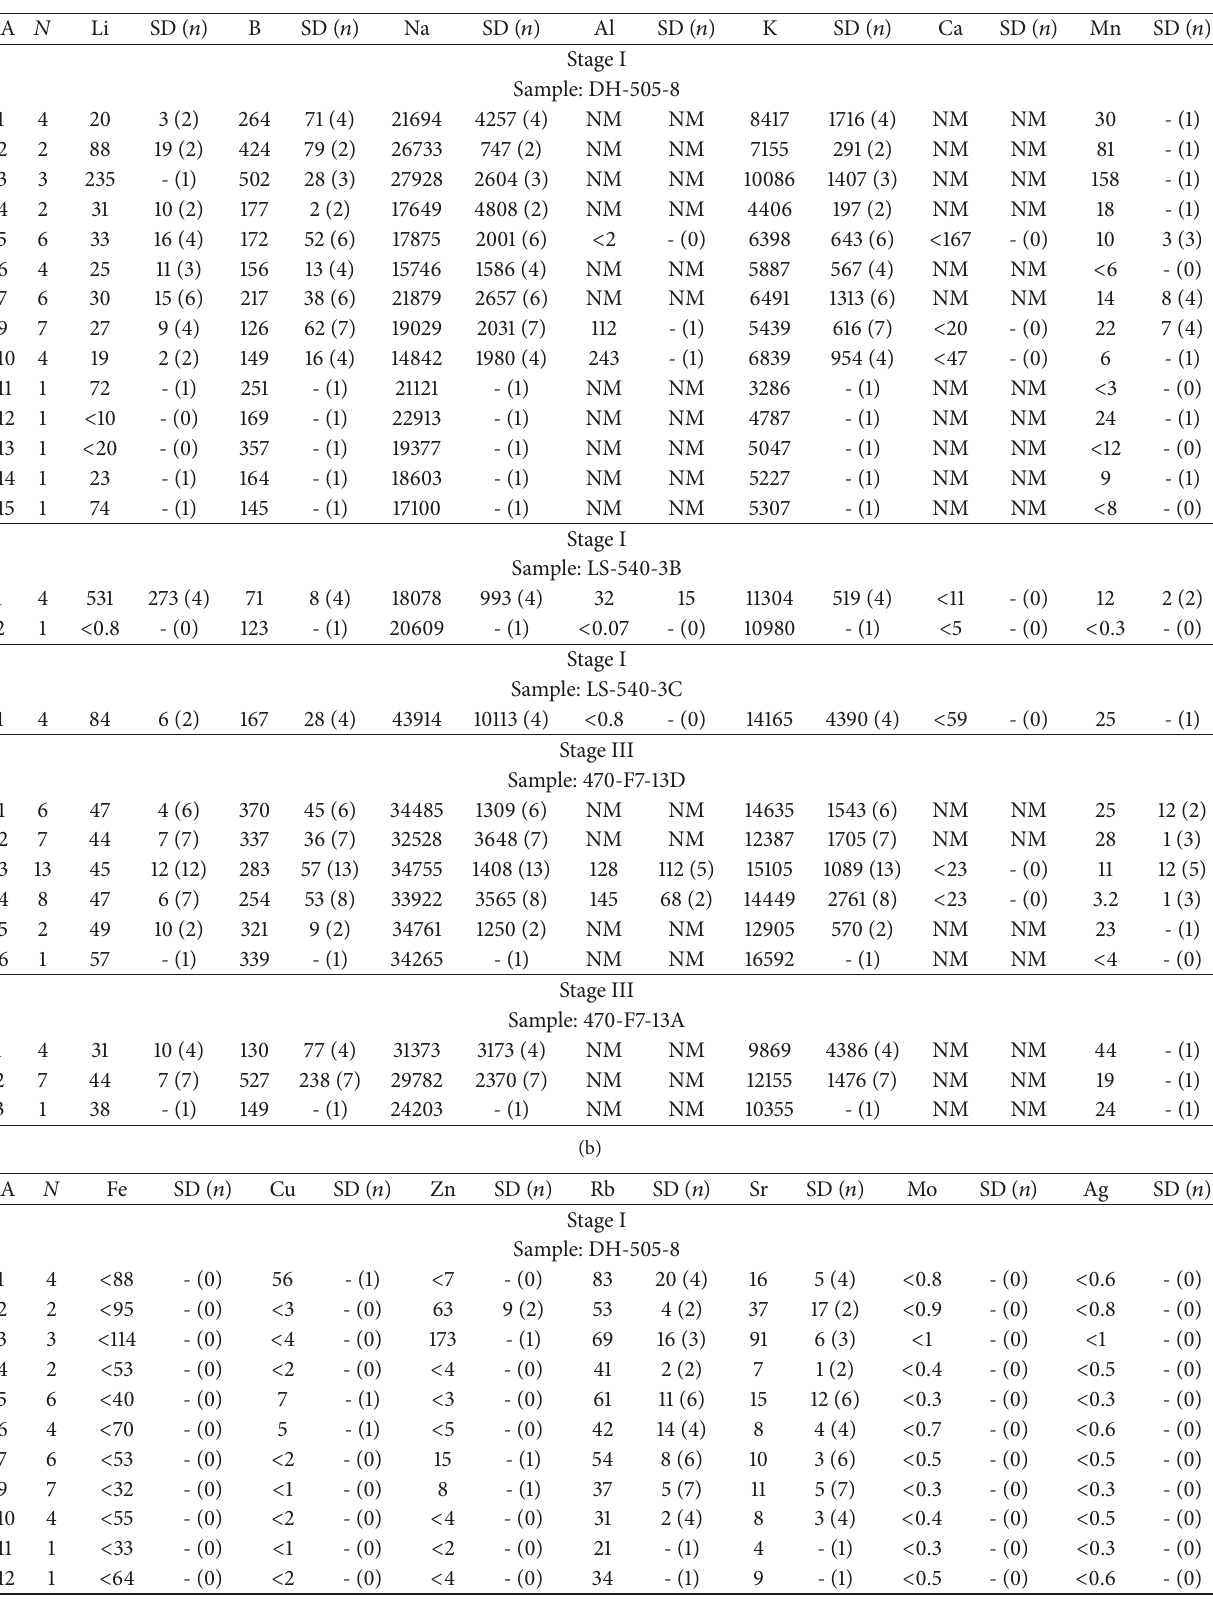
Table 1: Element concentrations (ppm) in solid-free fluid inclusion assemblages (FIA) from Dahu stage I and stage III